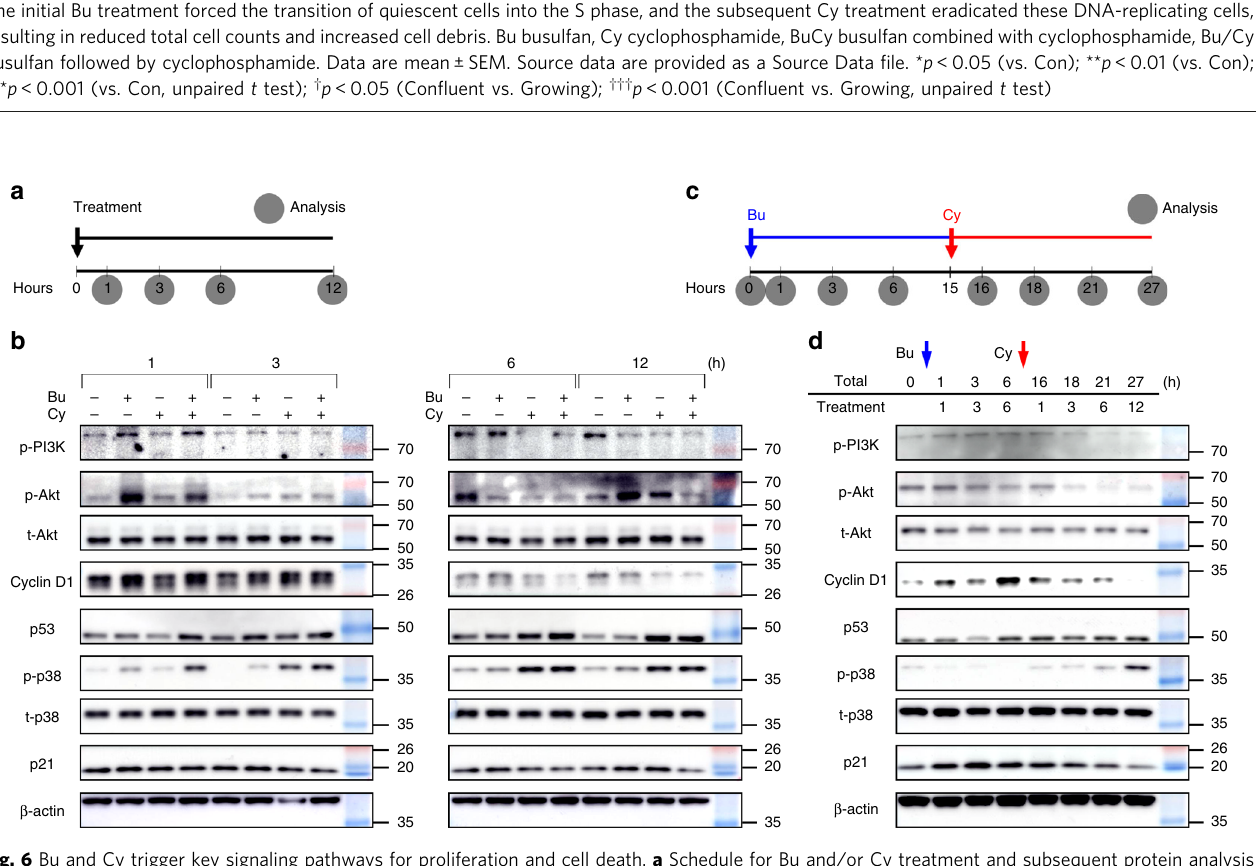
Fig. 6 Bu and Cy trigger key signaling pathways for proliferation and cell death. a Schedule for Bu and/or Cy treatment and subsequent protein analysis after 1, 3, 6, and 12 h of treatment. b Protein analysis after Bu and/or Cy treatment comparing the concentrations of phosphorylated PI3K, phosphorylated and total Akt, cyclin D1, p53, phosphorylated and total p38, and p21, with β -actin as a loading control ( n = 6 biological samples, Supplementary Fig. 7). c Schedule for sequential Bu/Cy treatment and subsequent protein analysis after 0, 1, 3, 6, 16, 18, 21, and 27 h of treatment. d Protein analysis after sequential Bu/Cy treatment comparing the concentrations of phosphorylated PI3K, phosphorylated and total Akt, cyclin D1, p53, phosphorylated and total p38, and p21, with β -actin as a loading control ( n = 4 biological samples; Western blotting). Bu busulfan, Cy cyclophosphamide, Bu/Cy busulfan